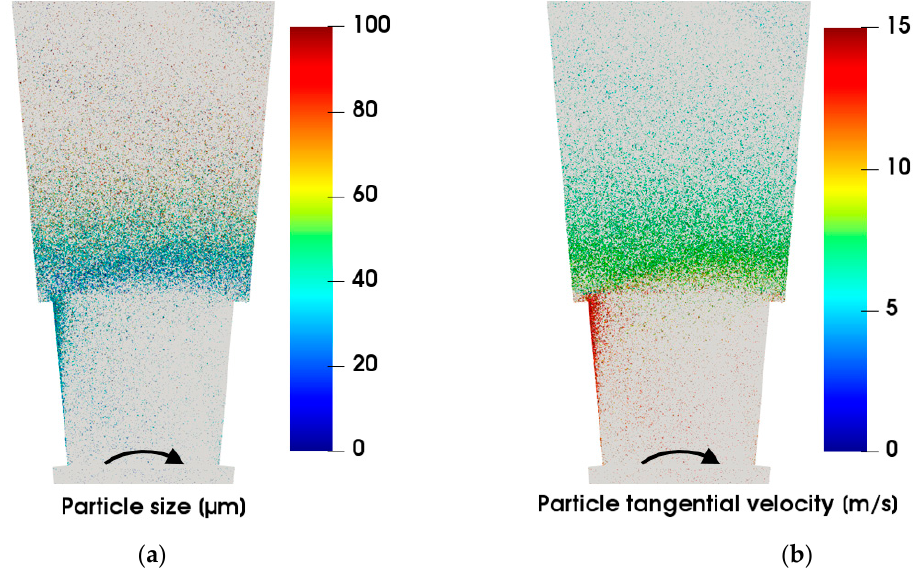
Figure 7. ( a ) Particle size in front of and between classifier blades at 900 rpm; ( b ) particle tangential velocity in front of and between classifier blades at 900 rpm.